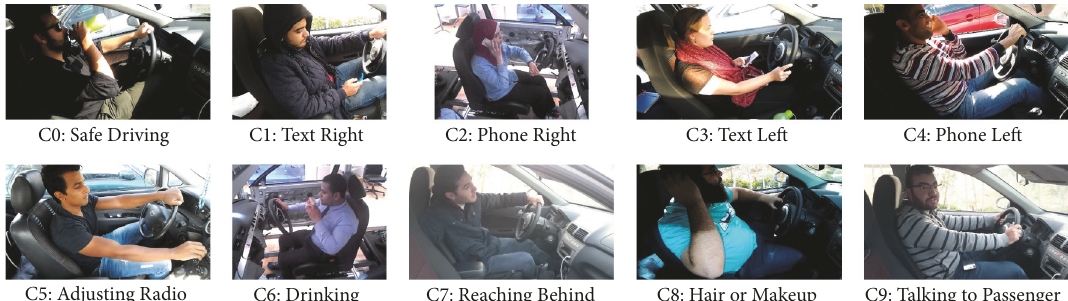
Figure 1: Ten classes of driver postures from our